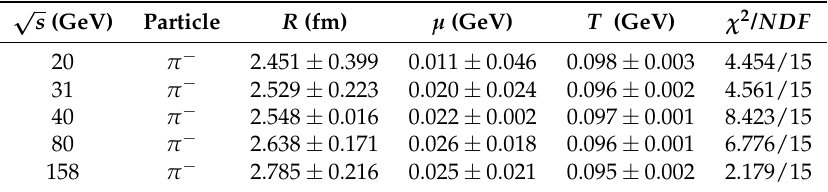
Table 5. The extracted values of T , µ , R and χ 2 / NDF parameters, using the data published in [14] for pp collisions with the NA 61